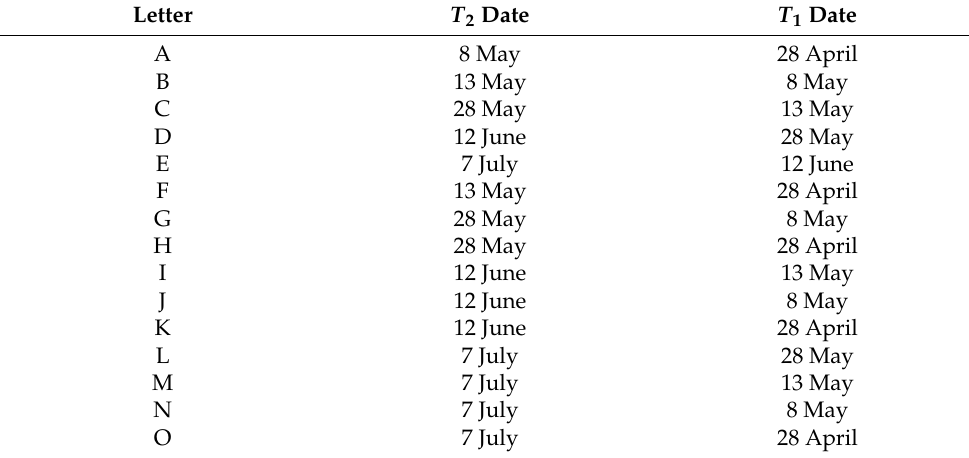
Table 4. Definition of each letter in Figure 4 in 2020 different time phases.